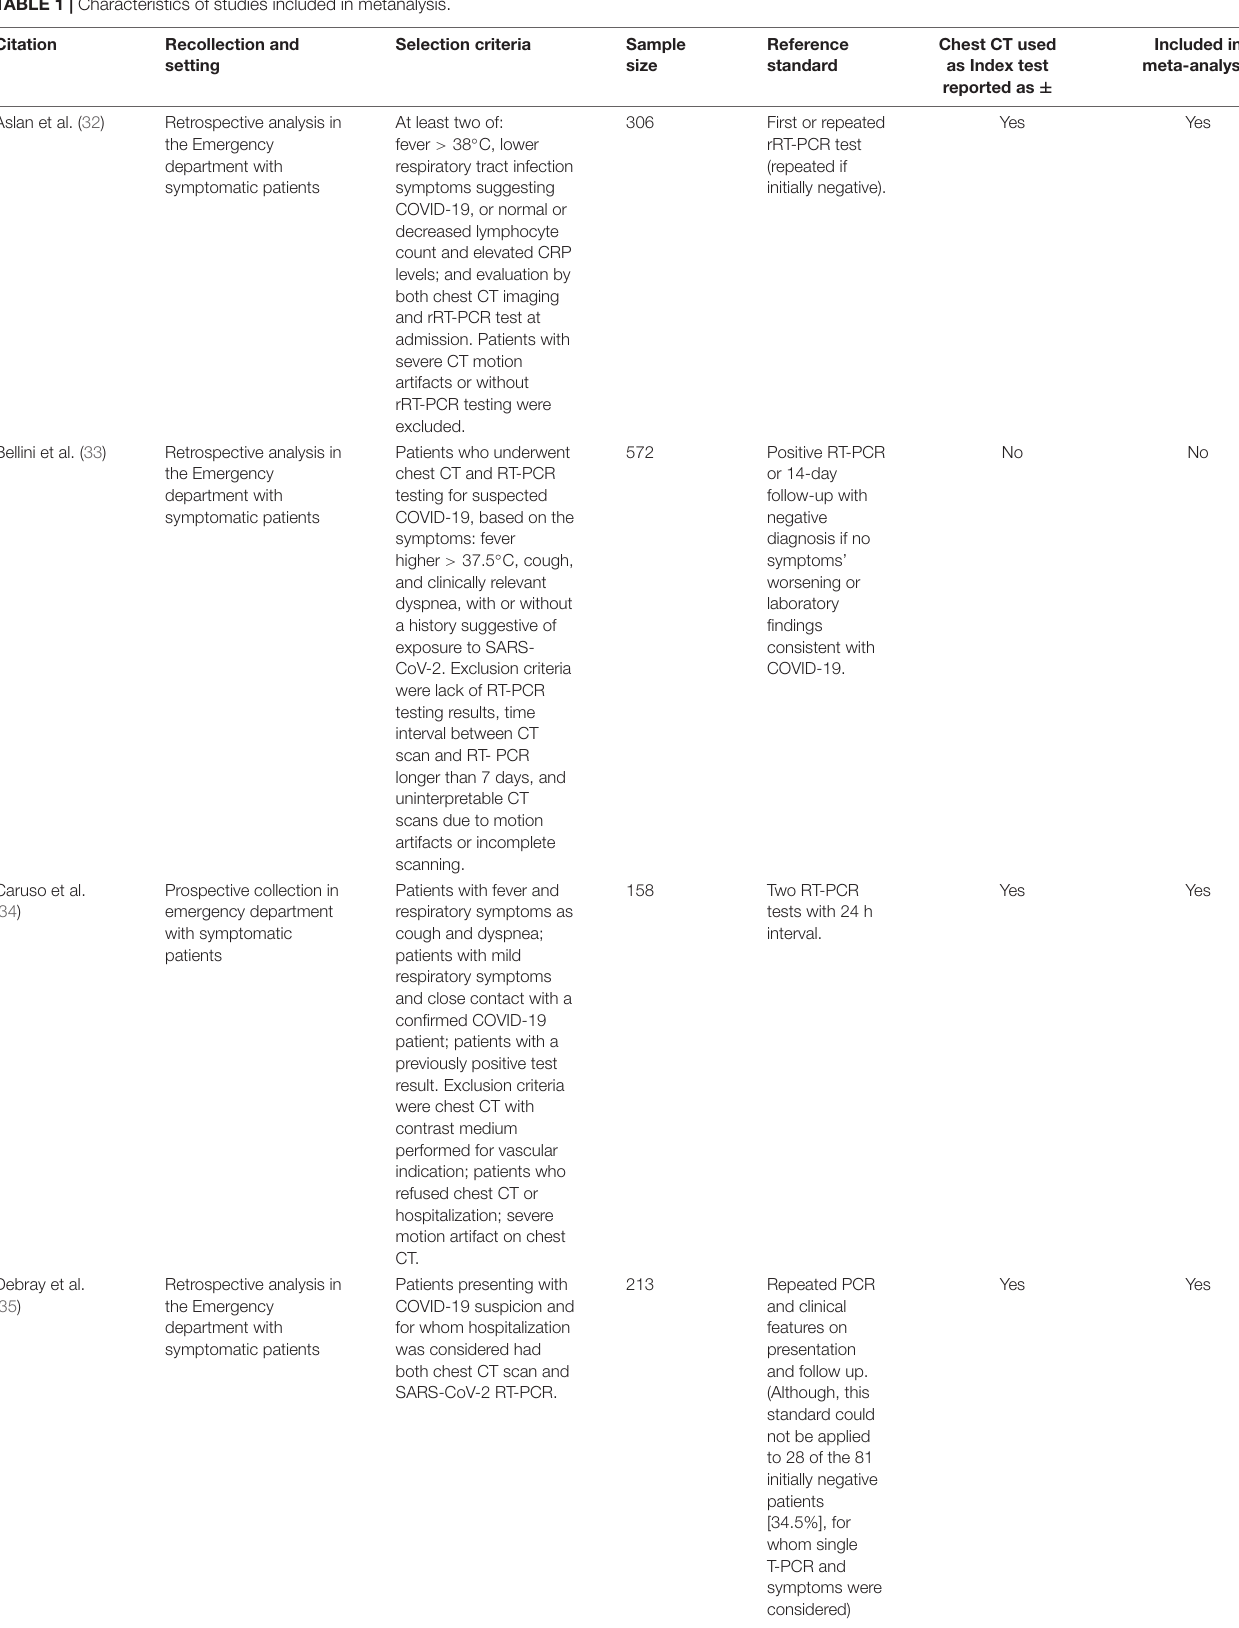
TABLE 1 | Characteristics of studies included in